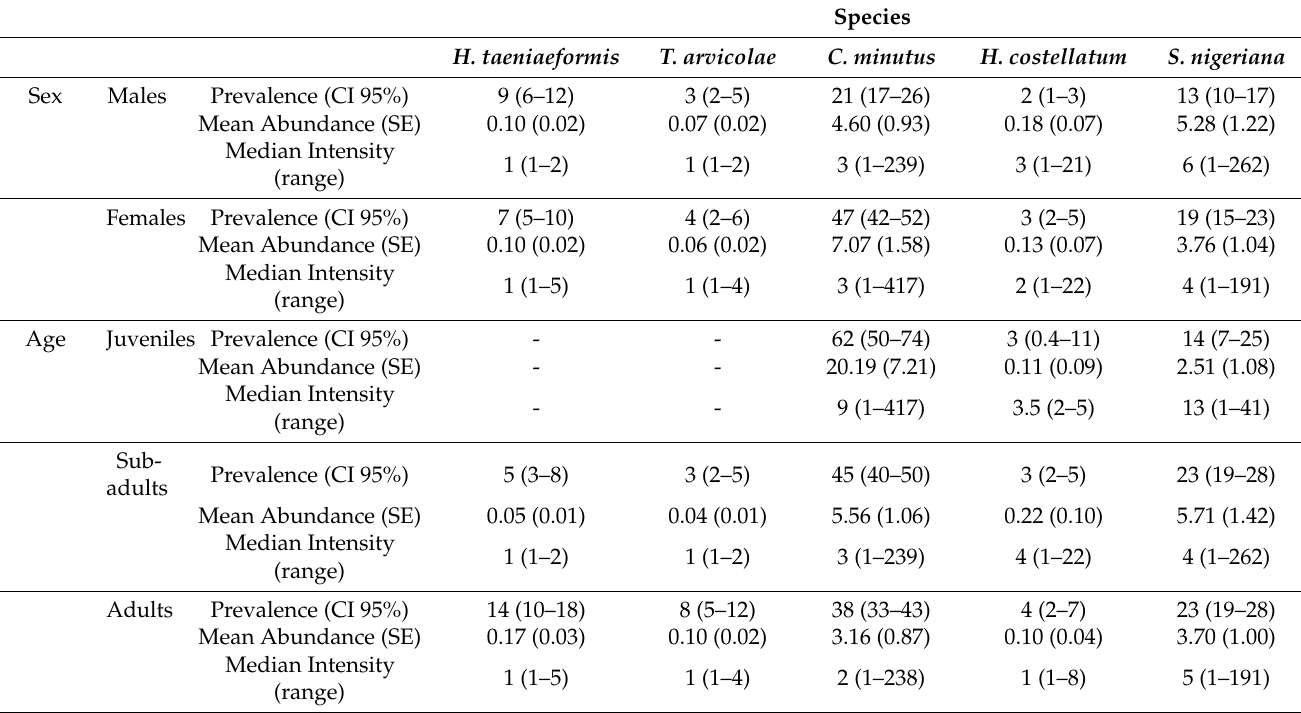
Table 5. Selected characteristics of the five most prevalent helminth species by host sex and age. CI—confidence interval, SE—standard error.